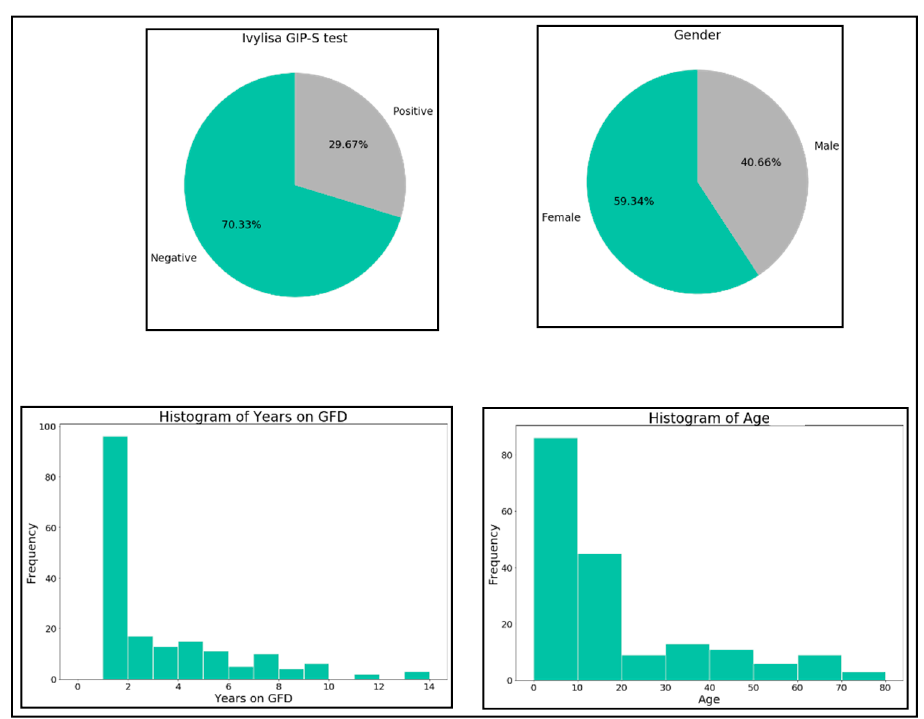
Figure 2. Distribution of the four variables.